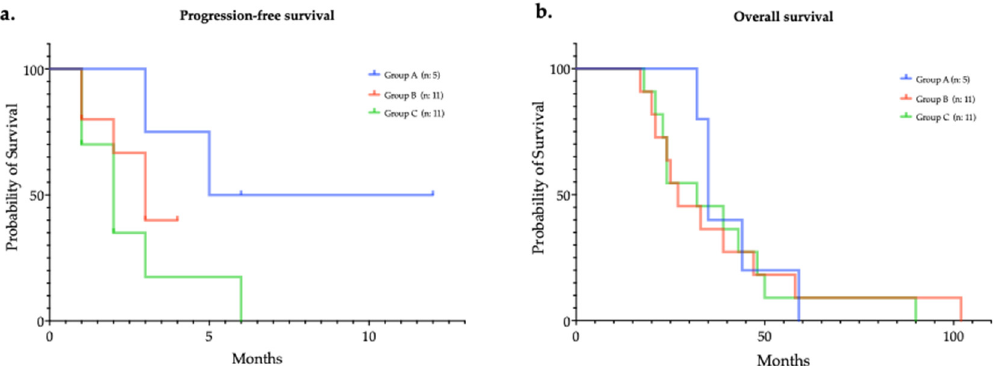
Figure 1. Response to platinum-based therapy according to molecular status phenotype . Responses are given for each group taken separately ( a ), or by comparing patients with or without molecular alteration (groups A + B versus group C respectively) ( b ). * represents differences with statistical significance ( p < 0.05).